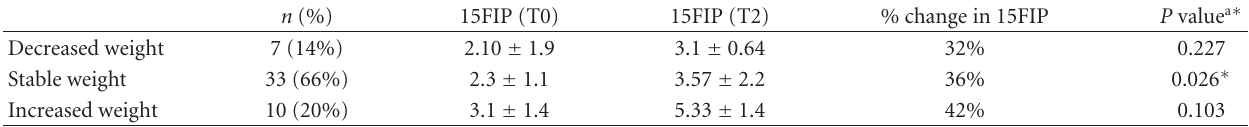
Table 6: Changes in 15FIP according to weight status before and after